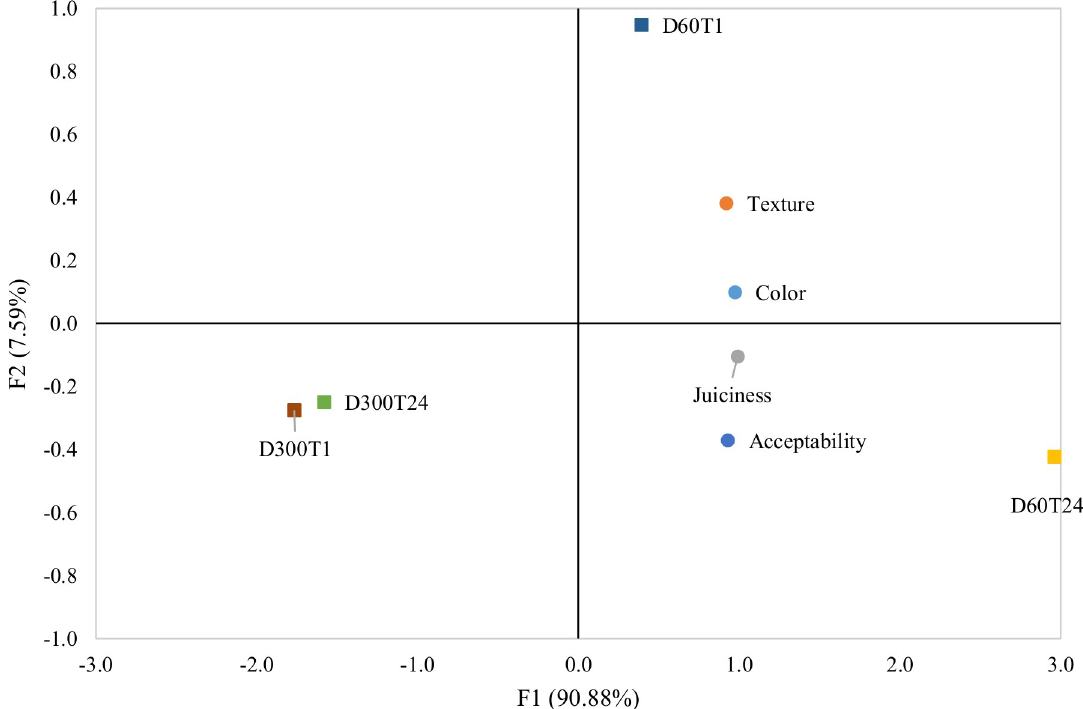
Fig 3. Principal components analysis. D60T1, density of 60 kg m -3 for 1 hour; D60T24, density of 60 kg m -3 for 24 hours; D300T1, density of 300 kg m -3 for 1 hour; and D300T24, density of 300 kg m -3 for 24 hours.